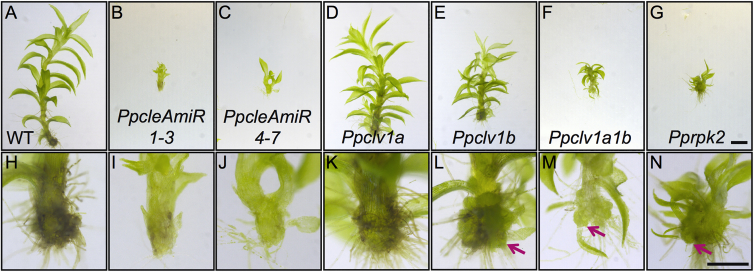
Gametophore Phenotypes in PpAmiRcle, Ppclv1, and Pprpk2 Mutants(A–G) Light micrographs showing height differences between WT (A), PpcleAmiR1-3 (B), PpcleAmiR4-7 (C), Ppclv1a (D), Ppclv1b (E), Ppclv1a1b (F), and Pprpk2 (G) gametophores dissected from 1-month-old plants. The scale bar represents 1 mm.(H–N) Light micrographs of gametophore bases with arrows showing overproliferation in Ppclv1b (L), Ppclv1a1b (M), and Pprpk2 (N) mutants. WT (H), PpcleAmiR1-3 (I), PpcleAmiR4-7 (J) and Ppclv1a (K) gametophores show no such overproliferation. The scale bar represents 0.5 mm.